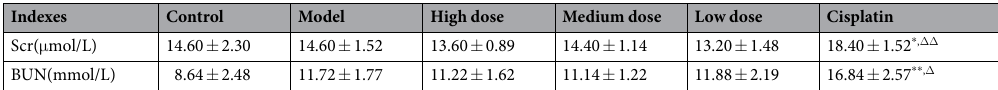
Table 2. Effect of GLE on renal function in tumor-bearing mice. Note: * P < 0.05; ** P < 0.01, versus control values; Δ P < 0.05; ΔΔ P < 0.01, versus model